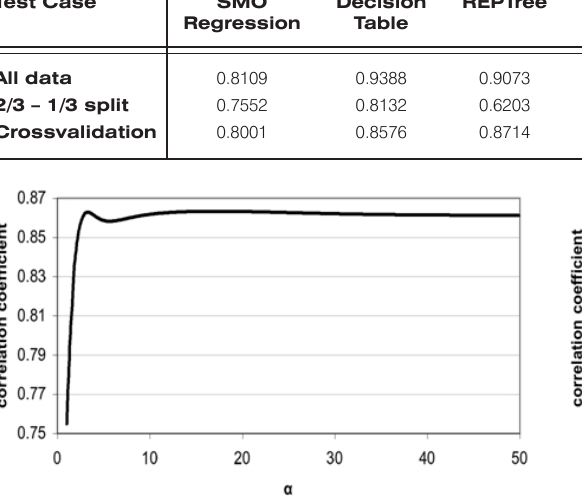
Table 1. Correlation coefficients obtained by different regression algorithms. Test Case